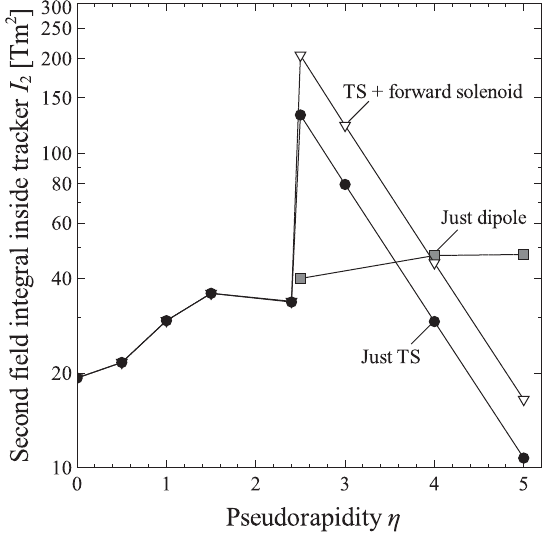
FIG. 8. Second field integral I 2 of the twin solenoid and the balanced forward solenoid versus the forward